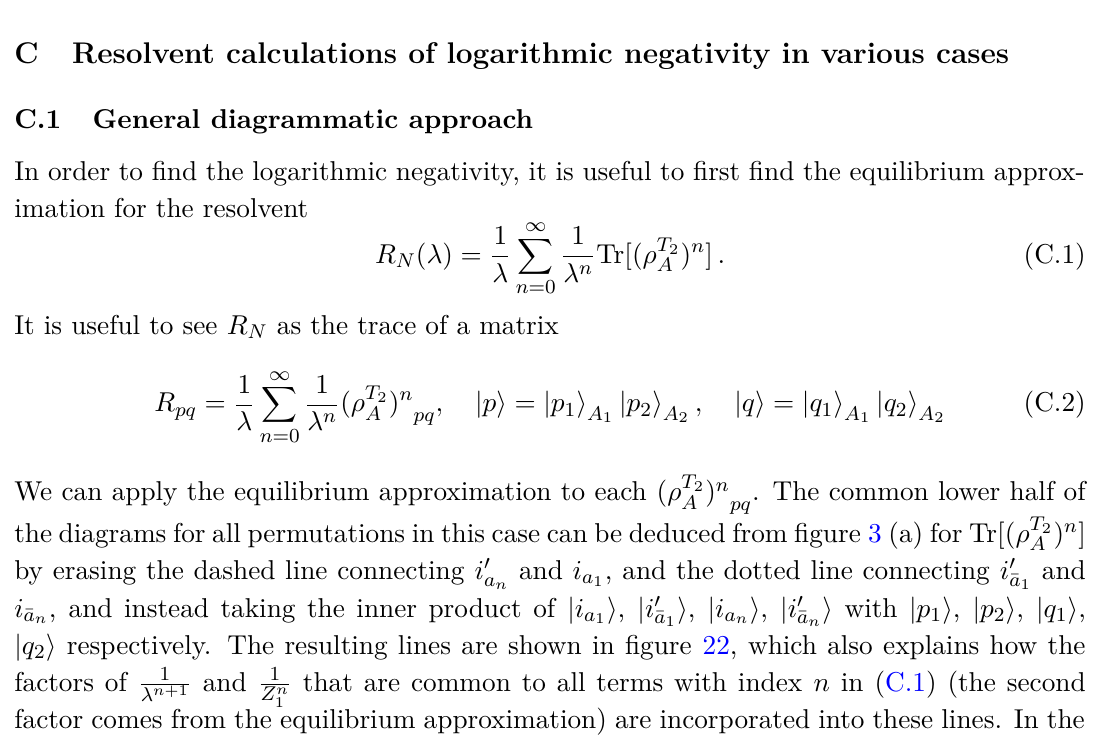
Finally, consider the PPT